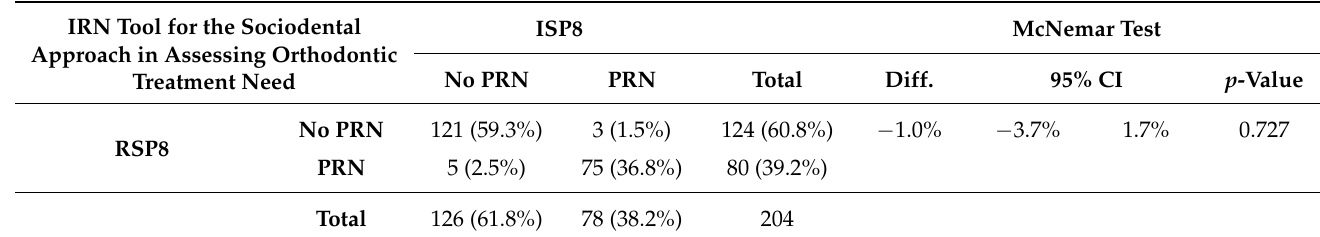
Table 5. Orthodontic treatment need using the sociodental model as estimated with different versions of the PIDAQ[M] as the impact-related need instrument (N =